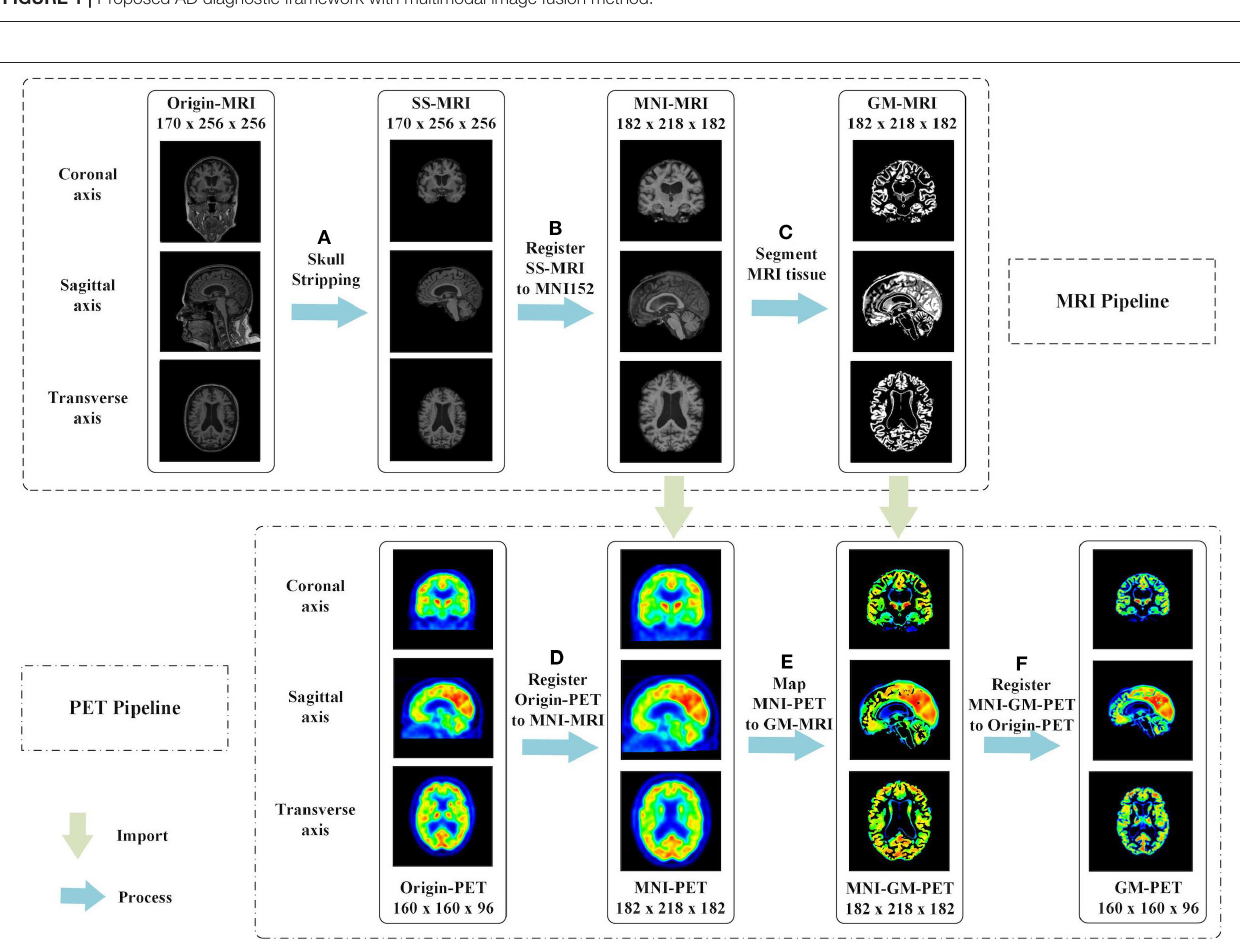
FIGURE 2 | Proposed multimodal image fusion method. In the MRI pipeline, we executed the following steps in sequence: (A) skull-stripping, (B) registration of SS-MRI to MNI152, and (C) segmentation of MRI tissue. The phased output of the MRI pipeline guided the subsequent processing of PET images, as shown by the green arrows. In the PET pipeline, we performed the following steps: (D) registration of Origin-PET to MNI-MRI, (E) mapping MNI-PET to GM-MRI, and (F) registration of MNI-GM-PET to Origin-PET.